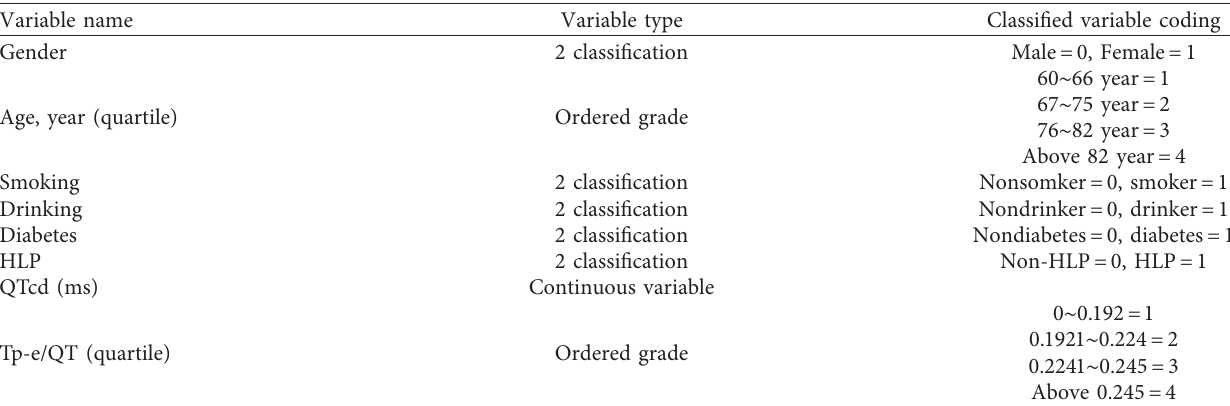
Table 2: Variable assignment